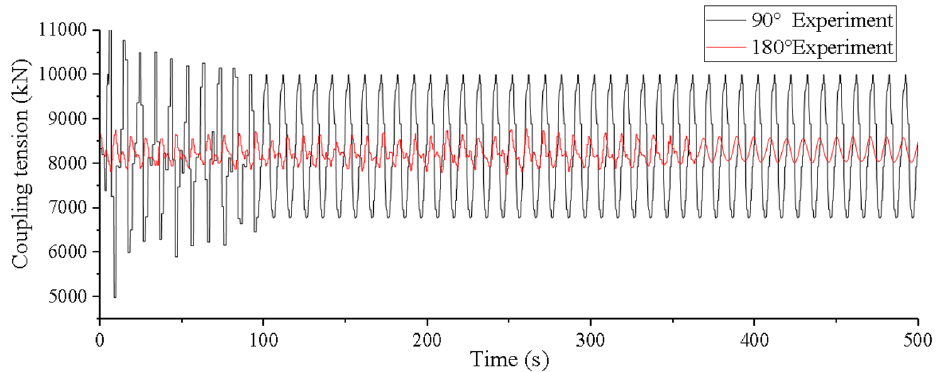
Figure 14. Time history of coupling tension under level 6 sea state in experiment (created by Origin 2017 software, URL: https:// www. origi nlab. com/).